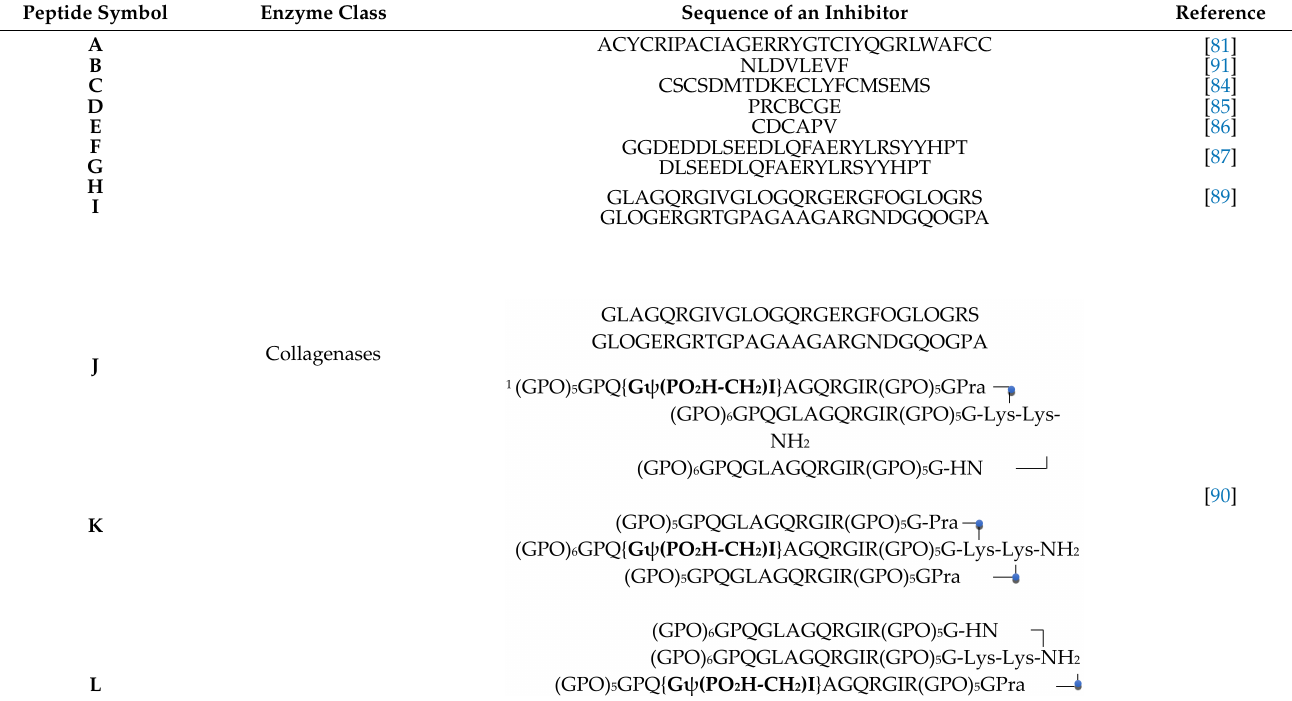
Table 7. Summary of unmodified peptide sequences exhibiting collagenases and elastases inhibition, together with peptide aldehydes inhibiting cathepsins, evaluated in this